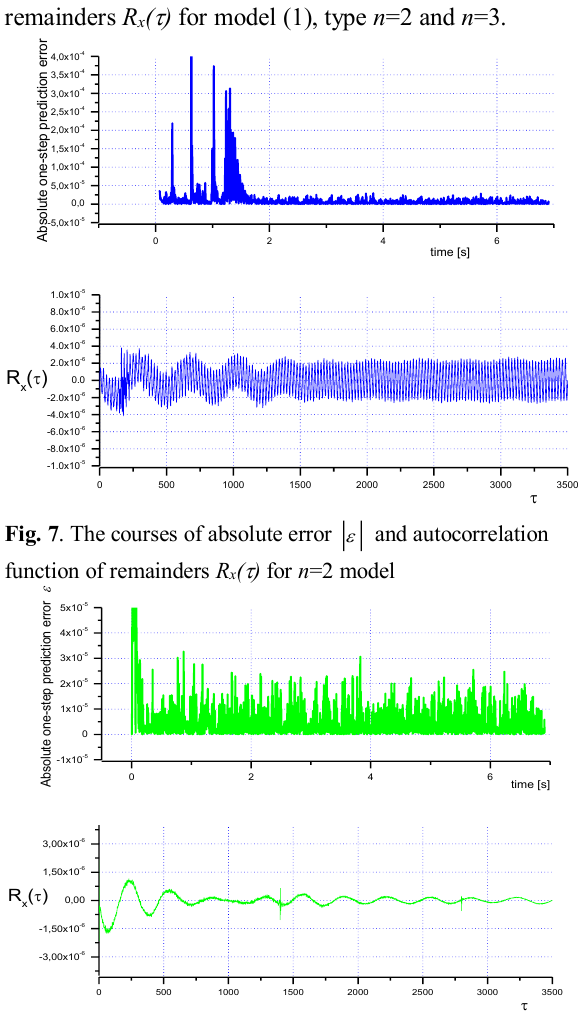
Fig. 8 . The courses of absolute error  and autocorrelation function of remainders R x (  ) for n =3